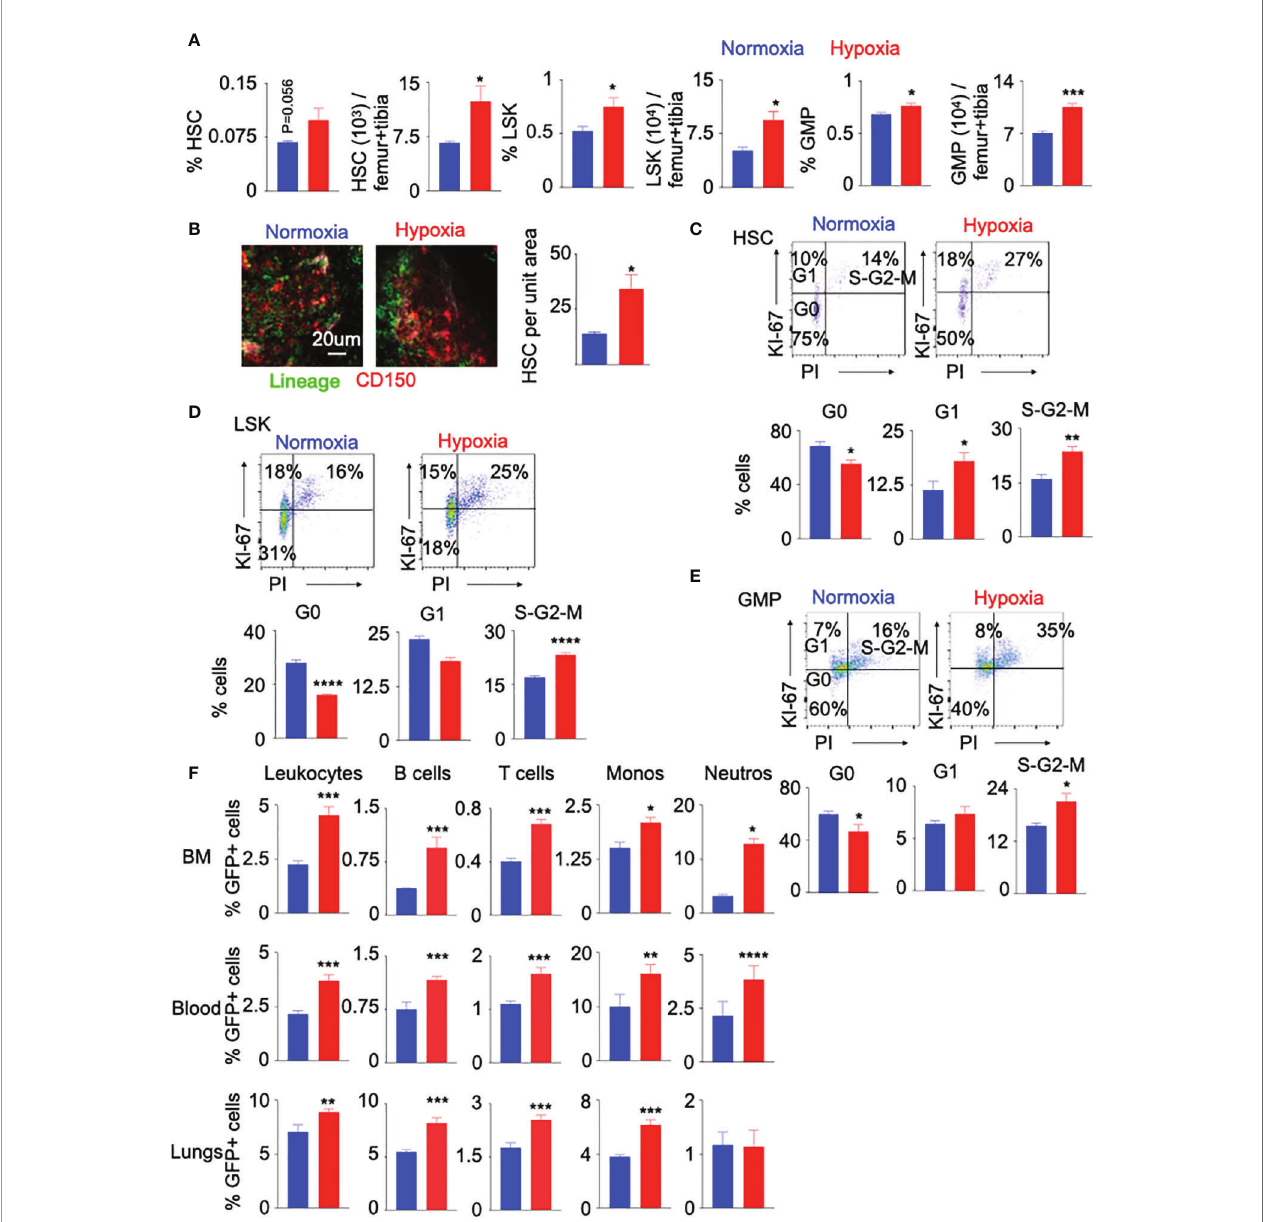
FIGURE 2 | Hypoxia drives HSPC into the cell cycle. C57BL/6 mice were placed under either normoxic or hypoxic conditions for 21 days. Bone marrow was collected. The frequencies and numbers of the hematopoietic progenitors in the bone marrow were determined by fl ow cytometry (A) and whole mount confocal microscopy (B) . The frequencies of HSC (C) , LSK (D) and GMP (E) in the cell cycle stages were assessed using intracellular staining of Ki-67 and PI. (F) KikGR- GFP + (Kikume Green Red) HSPC were adoptively transferred into mice housed in either normoxic or hypoxic conditions for seven days. GFP + progenies were quanti fi ed four days later. n = 5 mice per condition. Data are shown as mean ± s.e.m. *P < 0.05, **P < 0.01, ***P < 0.005, ****P <